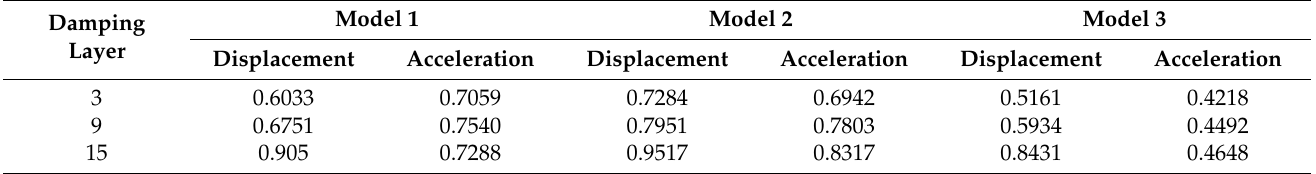
Table 3. Damping effects for the top floor response (Taft).